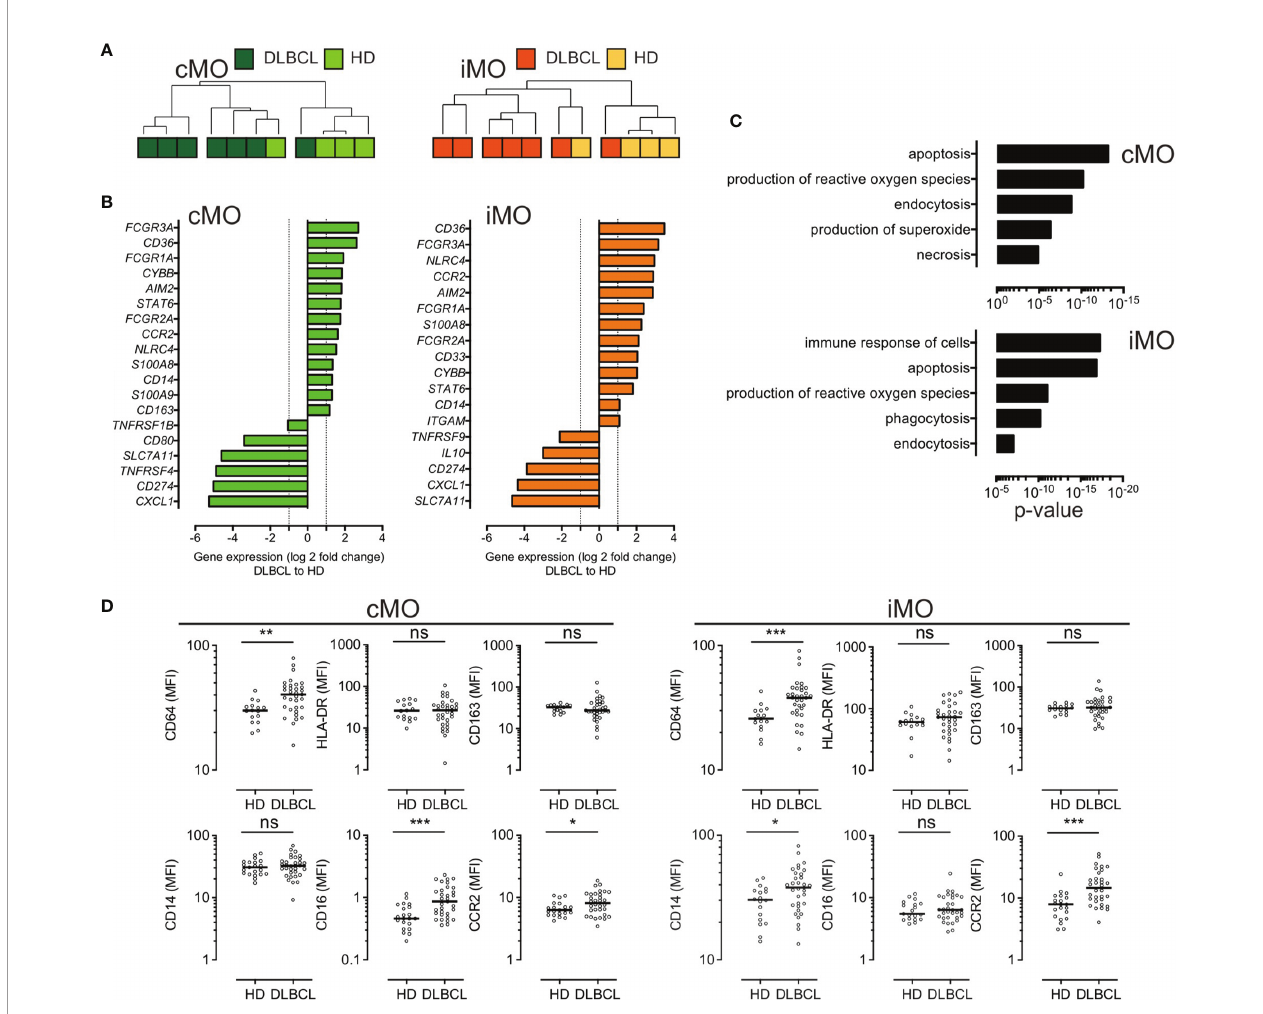
FIGURE 2 | Circulating cMOand iMO share a common in fl ammatory phenotype, inDLBCL. (A) Unsupervised hierarchical clustering of classical- (cMO)and intermediate- (iMO)monocytes, from HD (n= 4)and DLBCL (n= 7)samples. See Table S3 for a list of genes analyzed on monocyte subsets after cellsorting. Pearson ’ s correlation and complete linkage was employed. (B) Transcripts differentially expressed (P<.05; ∣ log2FC ∣ > 1)between DLBCLs and HDs, for cMOand iMO. (C) Predicted top 5 biological processes increasedfor cMOand iMO fromDLBCL(Ingenuity Pathway Analysis, z-score > 2.5, ranked by p-value). (D) Mean fl uorescence (MFI) for CD64, HLA-DR,CD163, CD14, CD16, and CCR2 for HD(n= 16) and DLBCL (n = 33) samples. Mann-Whitney test were performed. *P < .05, **P < .01, ***P < .001, ns, non-signi fi